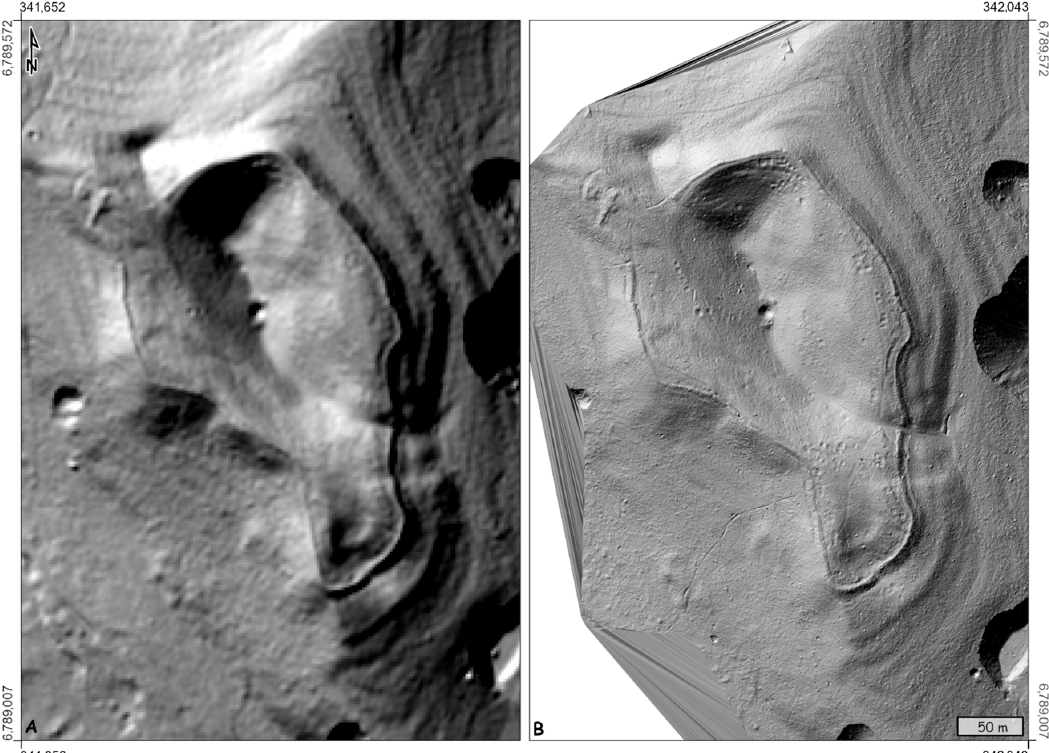
Figure 11. DTM of the Iron Age Rapola hillfort (Valkeakoski municipality) based on: ( A ) The open-access ALS data from the FNLS; ( B ) The University of Helsinki drone flight campaign (EPSG:3879 ETRS89/GK25FIN). (Illustration: Wesa Perttola and Oula Seitsonen).